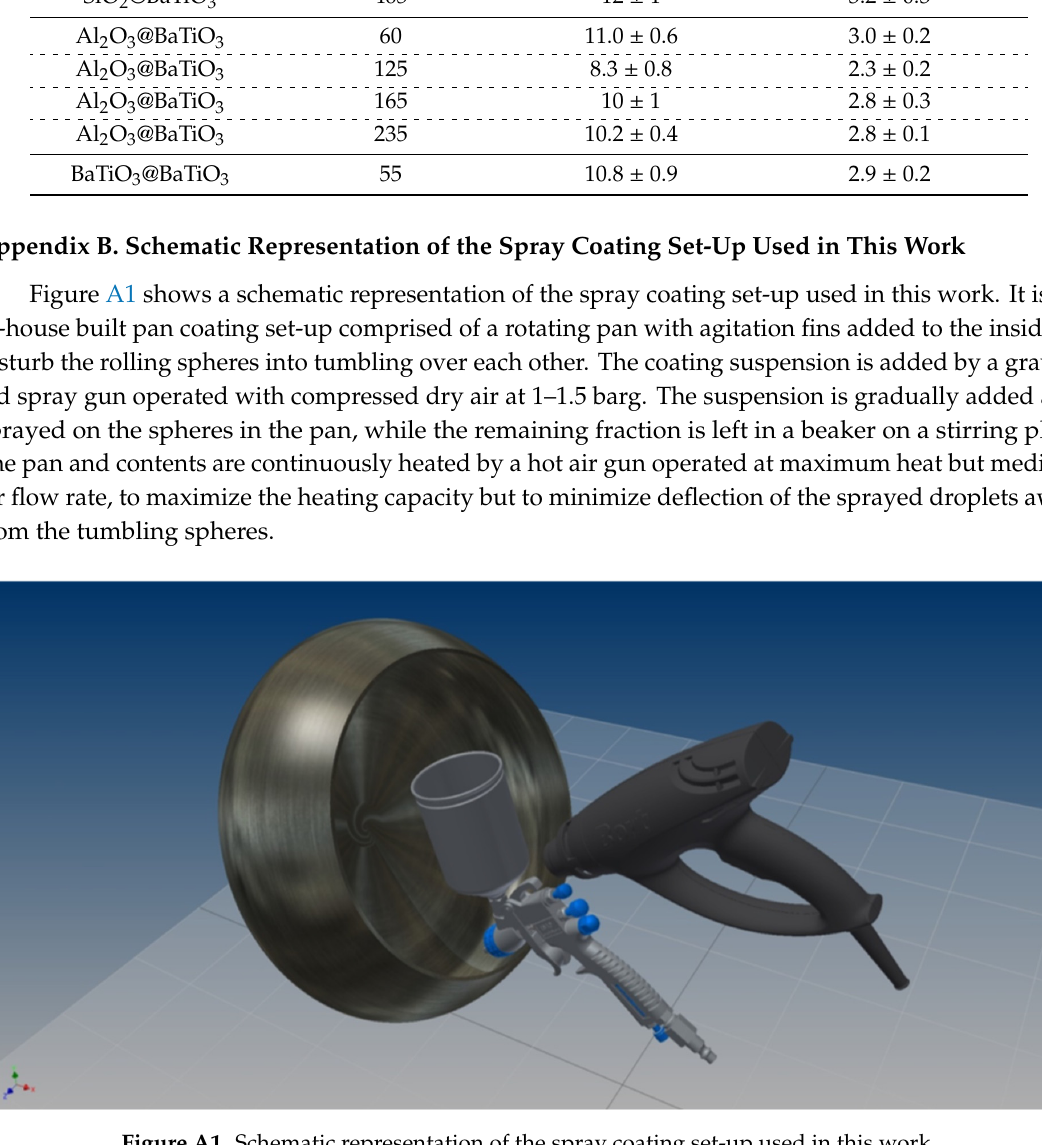
Figure B1. Schematic representation of the spray coating set-up used in this work. Figure A1. Schematic representation of the spray coating set-up used in this